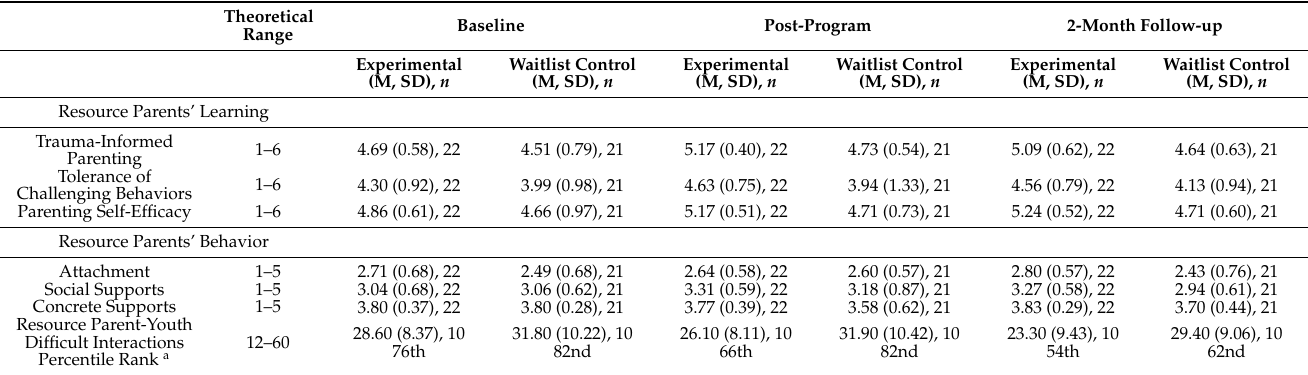
Table 1. Descriptive Statistics for Outcome Variables.